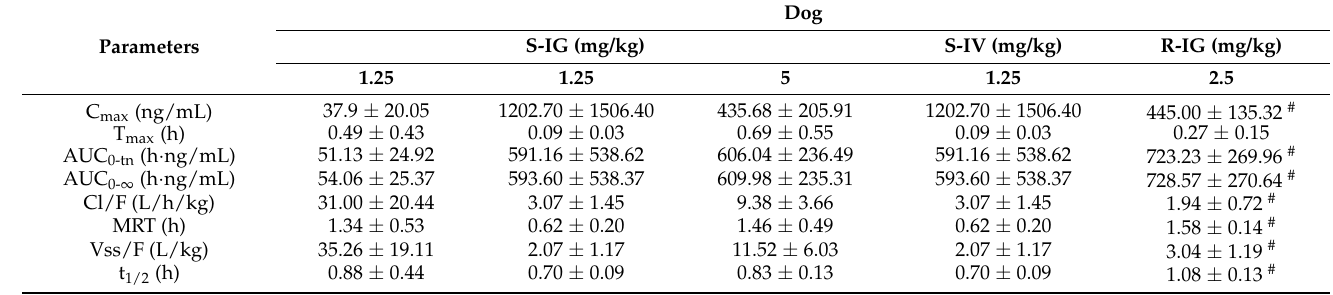
Figure 8. Comparison of the mean plasma concentration–time curves of HY-071085 after the single- dose intragastric administration of HY-071085 at low (1.25 mg/kg), medium (2.5 mg/kg) and high (5 mg/kg) doses in beagle dogs. ( A , B ): Constant coordinates; ( C , D ): semilogarithmic coordinates.